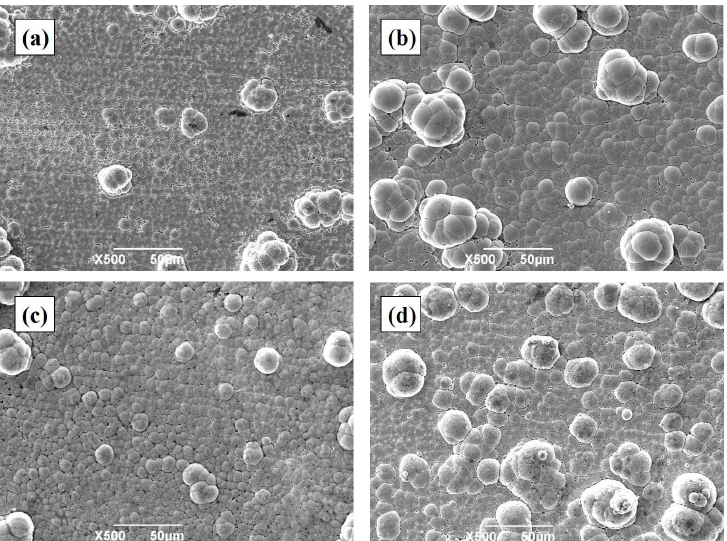
WO concentrations. (a) 5 g/L (b) 10 g/L (c) 15 g/L (d) 20 2 4